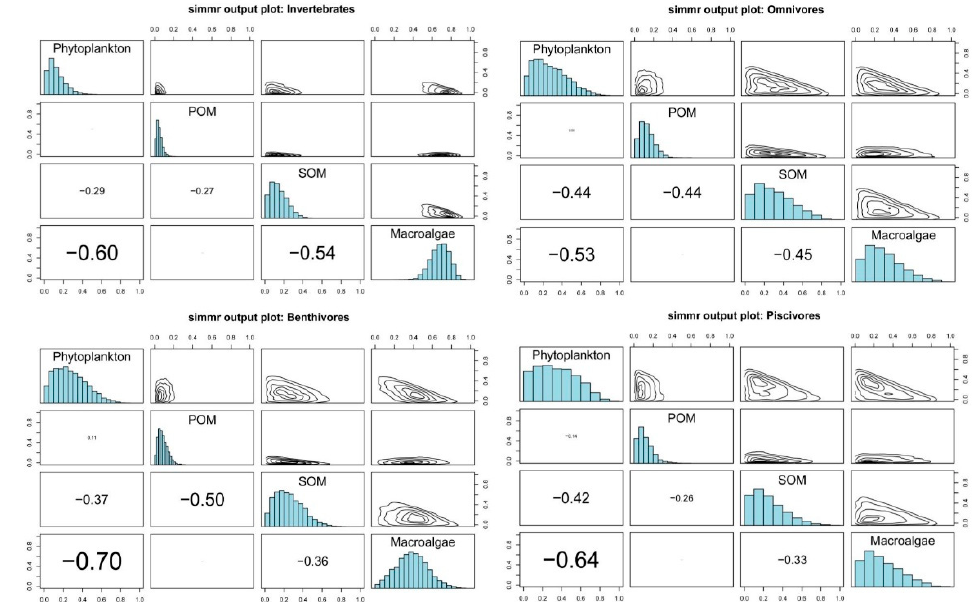
Figure 6. The matrix plot of the contribution of different base carbon sources to consumers. This shows the source histograms on the diagonal, contour plots of the relationship between the sources on the upper diagonal, and the correlation between the sources on the lower diagonal. Large negative correlations indicate that the model cannot discern between the two sources; in general, high correlations (negative or positive) are indicative of the model being unable to determine which food sources are being consumed, and are an unavoidable part of stable isotope mixing